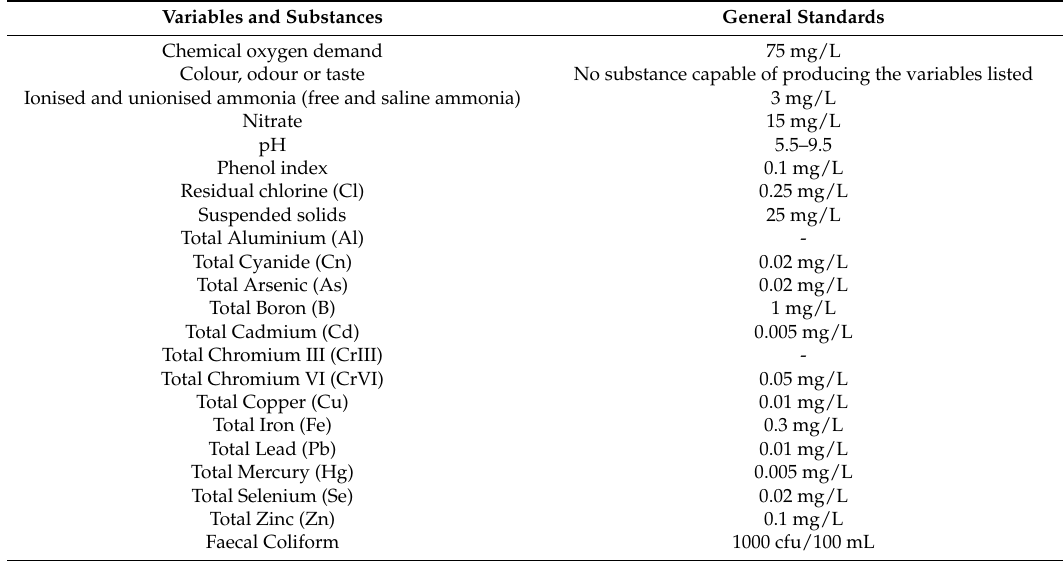
Table 4. South African National Water Act waste discharge standard